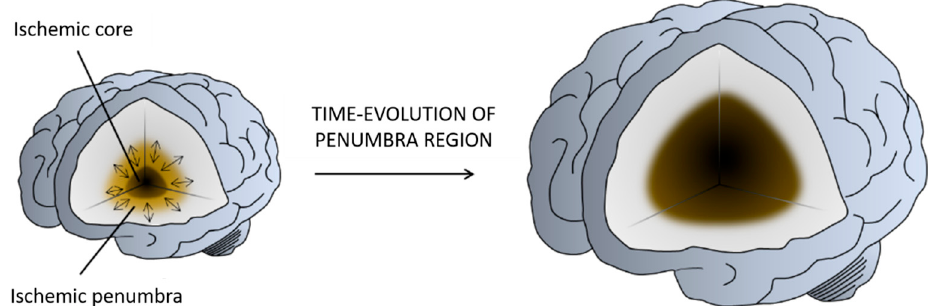
Figure 2. Illustration of the penumbra concept. Ischemic core represents the infarcted tissue and the penumbra region the salvageable tissue at risk for infarction in case of persistence vessel occlusion. While neurons in the ischemic core are considered beyond rescue, neurons in the penumbra are potential targets for therapeutic intervention. Figure created with BioRender.com.